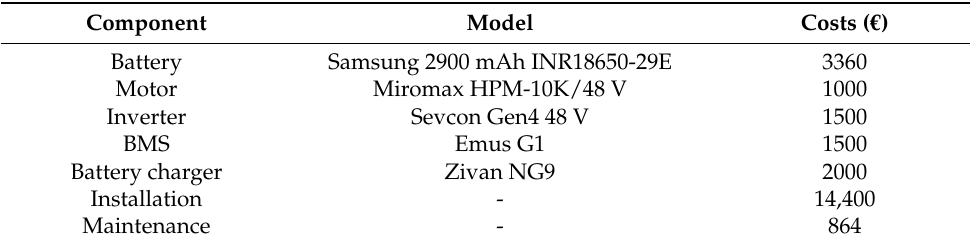
Table 2. Costs related to the e-HPS